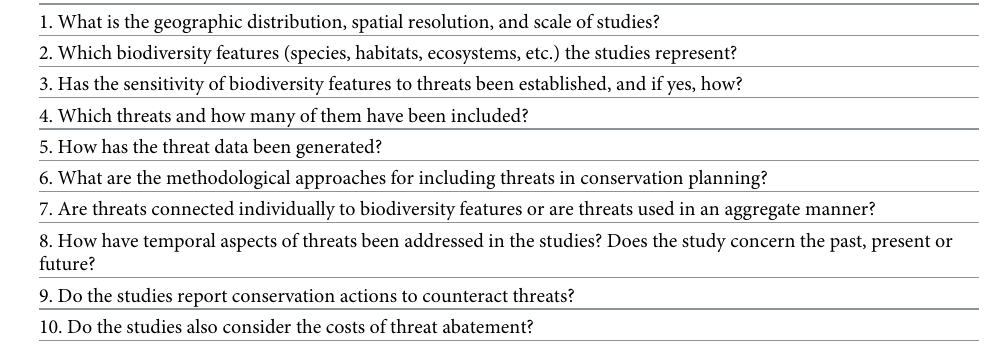
Table 1. Secondary research questions for the systematic